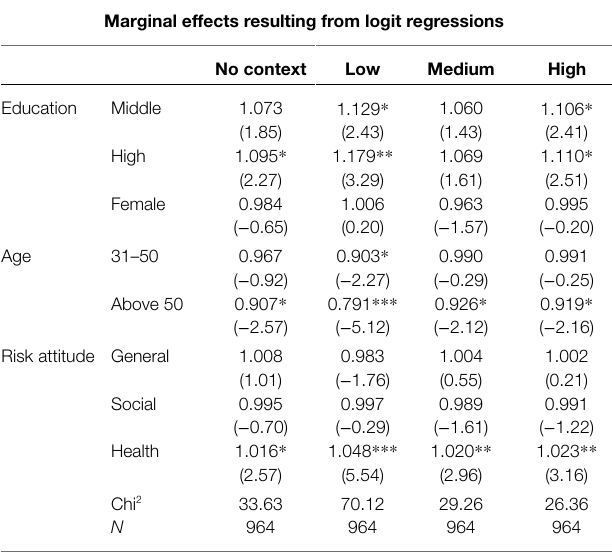
TABLE 6 | Logit regressions: location-dependent characteristics and decision to